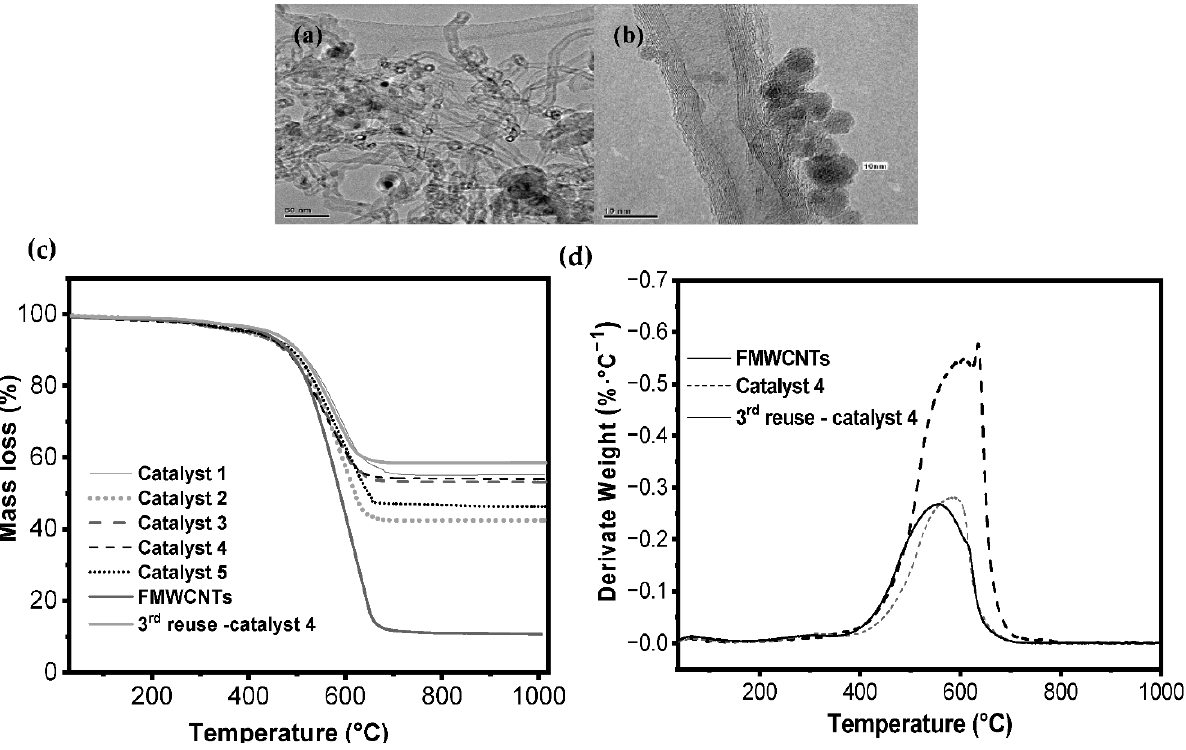
Figure 1. TEM images of ( a ) FMWCNTs, ( b ) third reuse-catalyst 4; TGA analysis of ( c ) magnetic catalysts, FMWCNTs and third reuse of catalyst 4; and ( d ) derivate weight of FMWCNTs, catalyst 4 and its third reuse.